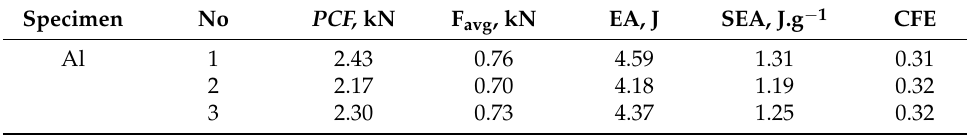
Table A1. Axial crashworthiness indicators of each